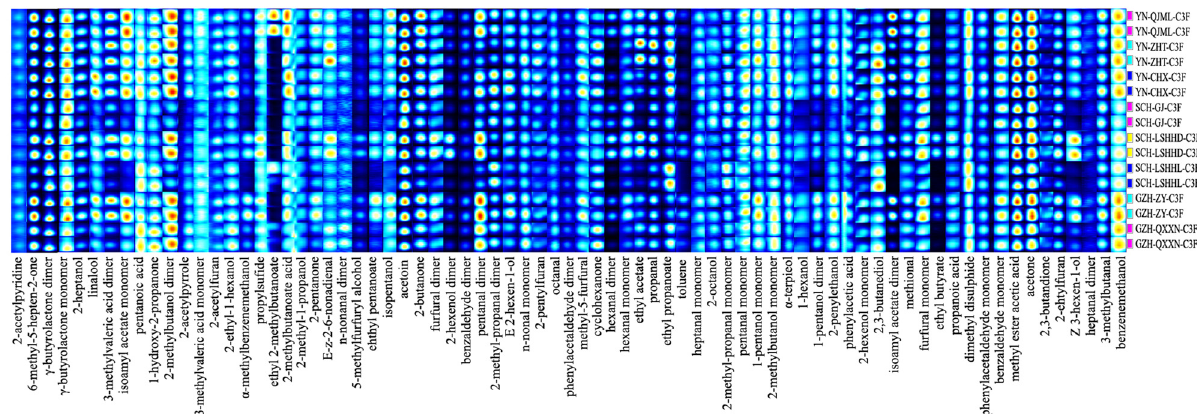
Figure 3: Fingerprints of volatile organic compounds